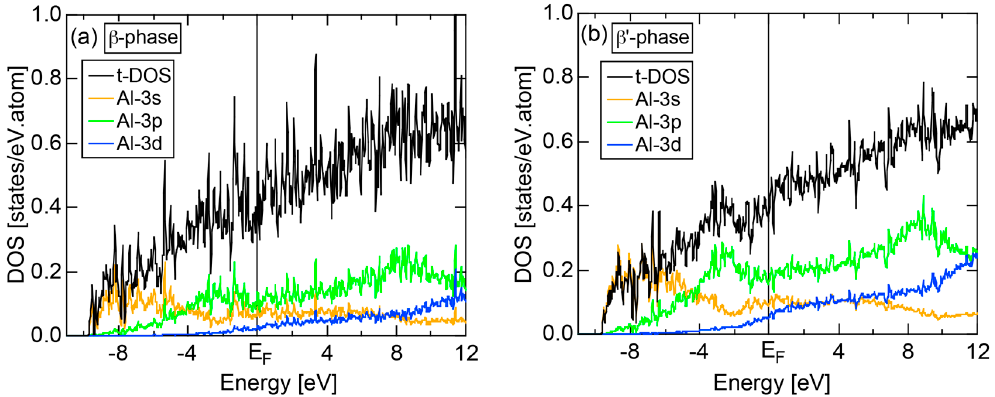
Figure 49. Total-DOS and Al-pDOSs for ( a ) β - and ( b ) β ′ -phase Al 3 Mg 2 compounds [11]. The FLAPW-Fourier spectra , C max2 and Hume-Rothery plots for β - and β ′ -phases are displayed